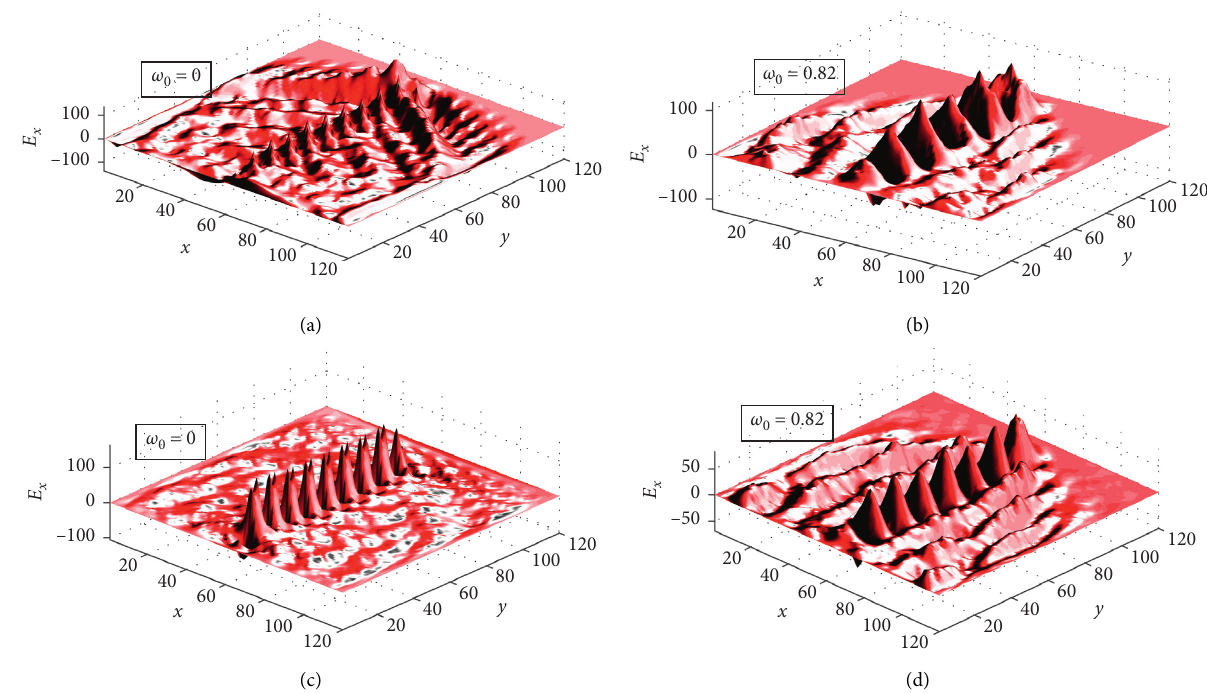
Figure 8: (Color on line) snapshots the field E � 0, the Cherenkov cone is well defined with oscillations in the path of the charge. (b) Field E for ω 0 is observed, with a lower number of oscillations than subsection (a) due to the modulation of the source. (c) ω the charge; however, in this case, we did not observe the group cone. (d) Cherenkov group cone for ω